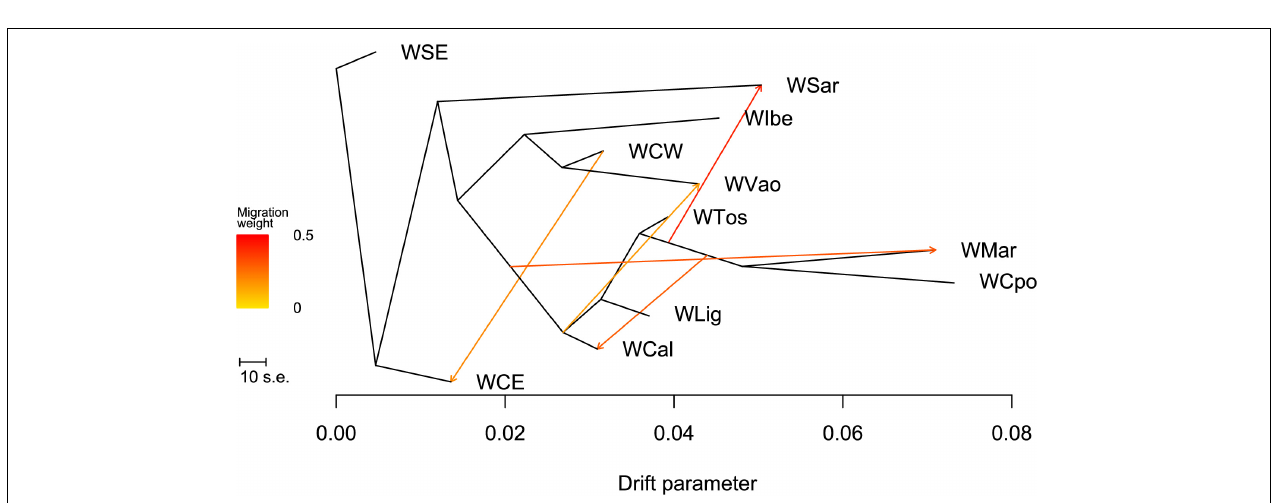
FIGURE 5 | Principal component analysis (PCA) of Italian and European wild boar genotypes. PCA was first calculated excluding the three Italian populations of WLig, WTos, and WCal, whose genotypes were added afterward by projecting their a posteriori estimated coordinates. Plots refer to the following pairwise combinations: PC1 vs. PC2 (A) , PC1 vs. PC3 (B) , and PC2 vs. PC3 (C) .